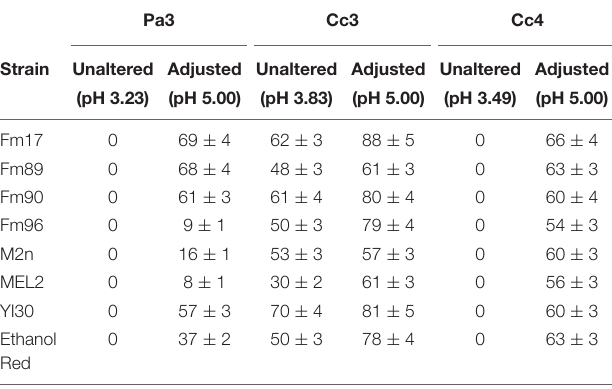
TABLE 5 | Influence of different lignocellulosic pre-hydrolysates on yeast growth in defined YNB medium supplemented with 20 g/L of glucose with or without pH adjustment to pH 5.0 with 5 M